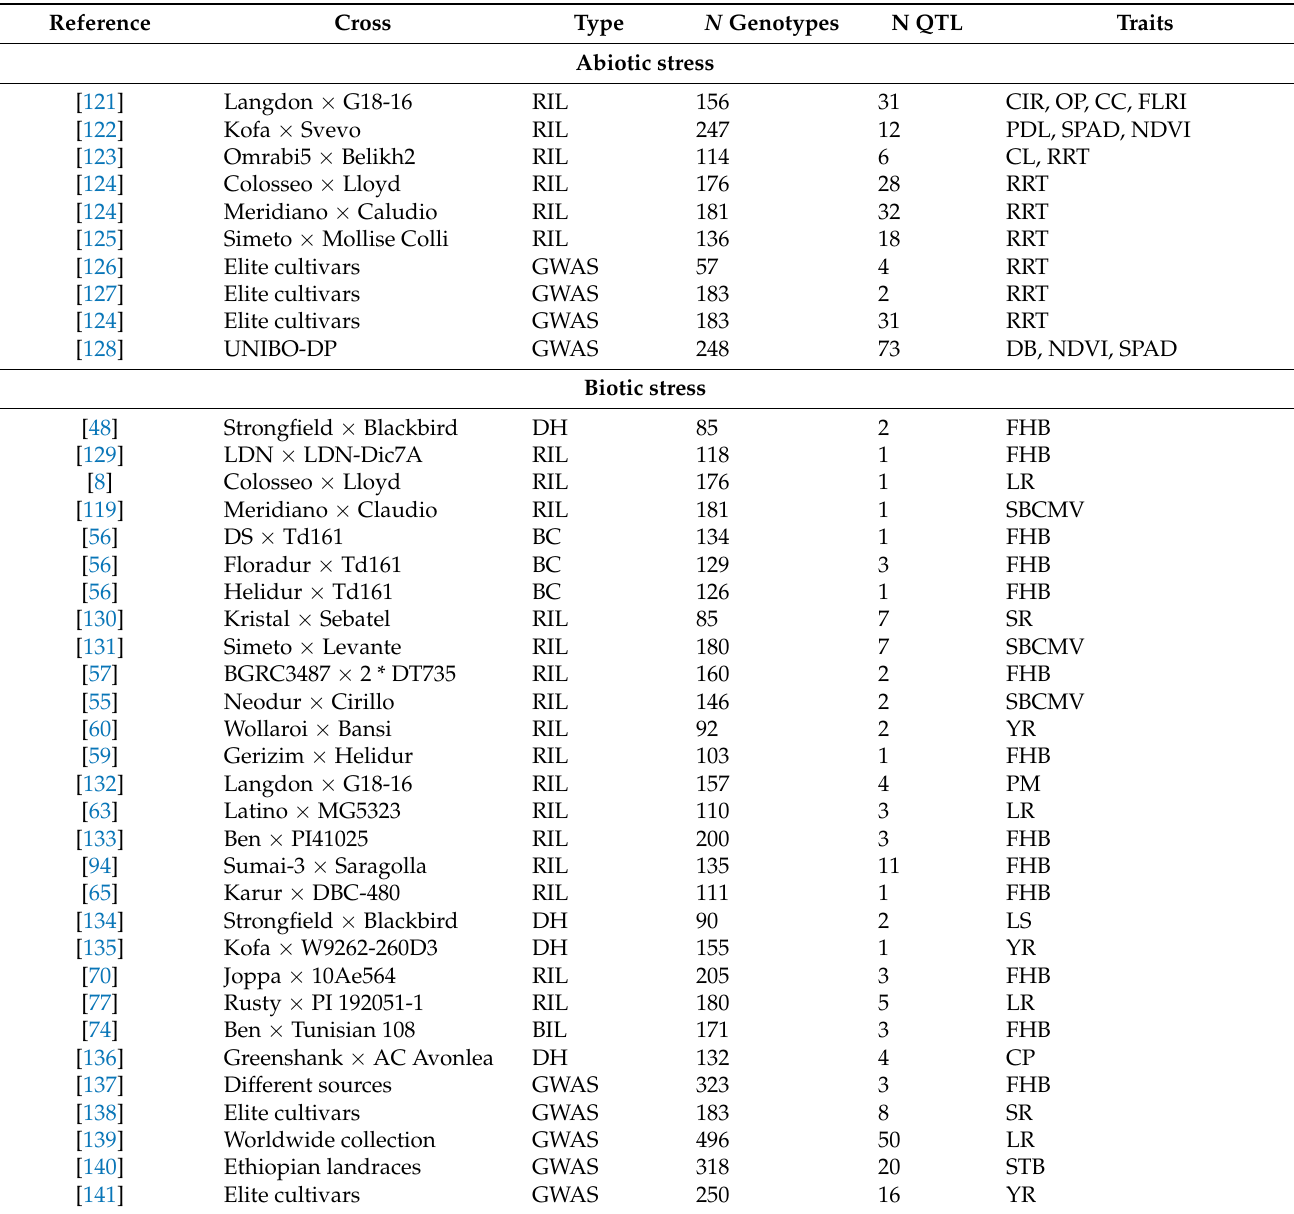
Table 2. Summary of quantitative trait loci (QTL) reviewed in the present